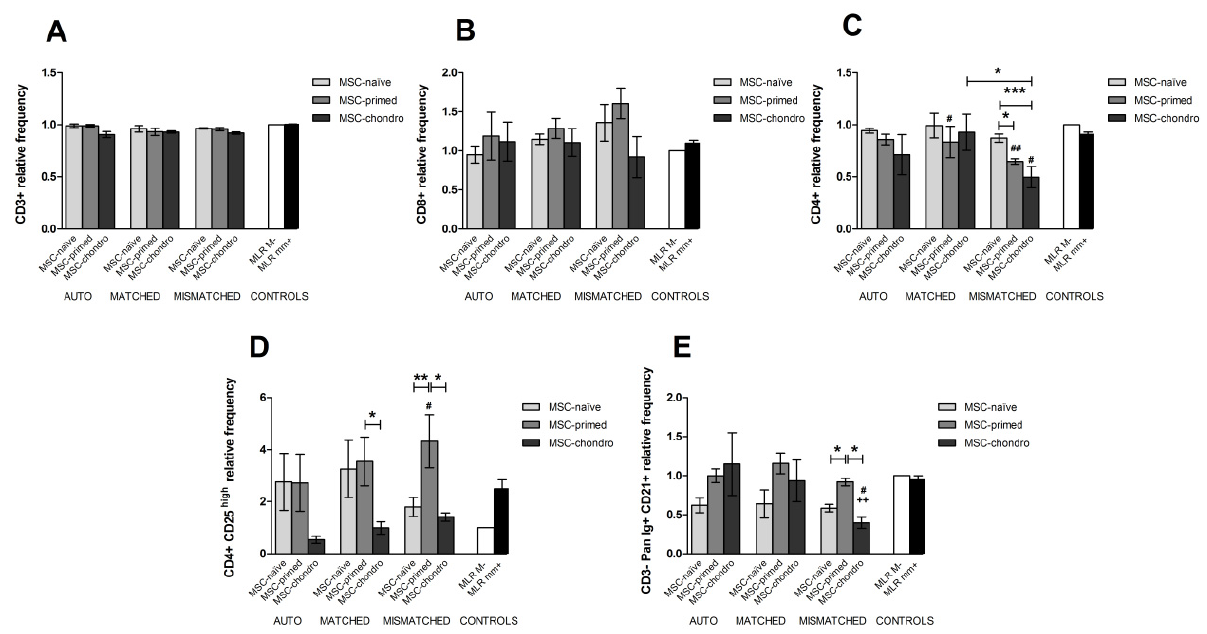
Figure 5. Mean ± SEM of the relative frequency of different lymphocyte subsets in the immunogenicity assays (one-way modified mixed lymphocyte reaction): ( A ) CD3+ T lymphocytes, ( B ) CD8+ cytotoxic T cells, ( C ) CD4+ helper T cells, ( D ) CD4+ CD25 high regulatory T cells, ( E ) CD3 − Pan-Ig+ CD21+ B cells. Non-activated PBLs were exposed in vitro to MSC-naïve (light grey bar), MSC-primed (medium grey bar) and MSC-chondro (dark grey bar). Co-cultures of MSCs and PBLs were autologous ( n = 3) or allogeneic, matched ( n = 8) or mismatched ( n = 7) for the MHC. Data from each PBL donor is normalised over the negative control (MLR M − , matched MLR) consisting of responder PBLs from the same donor exposed to MHC-matched stimulator PBLs (value 1), to account for inter-individual variability. Significant differences of each condition over the positive control (MLR mm+, mismatched MLR consisting of responder PBLs exposed to MHC-mismatched stimulator PBLs; black bar) are represented by a cross (+) above the corresponding bar (++ = p < 0.01). Significant differences over the negative control (MLR M − , white bar) are represented by hashes (#) above the corresponding bar (# = p < 0.05; ## = p < 0.01). Significant differences between experimental conditions are represented by a squared line with an asterisk (* = p < 0.05; ** = p < 0.01; *** = p < 0.001).